Question: What form of chart is displayed?
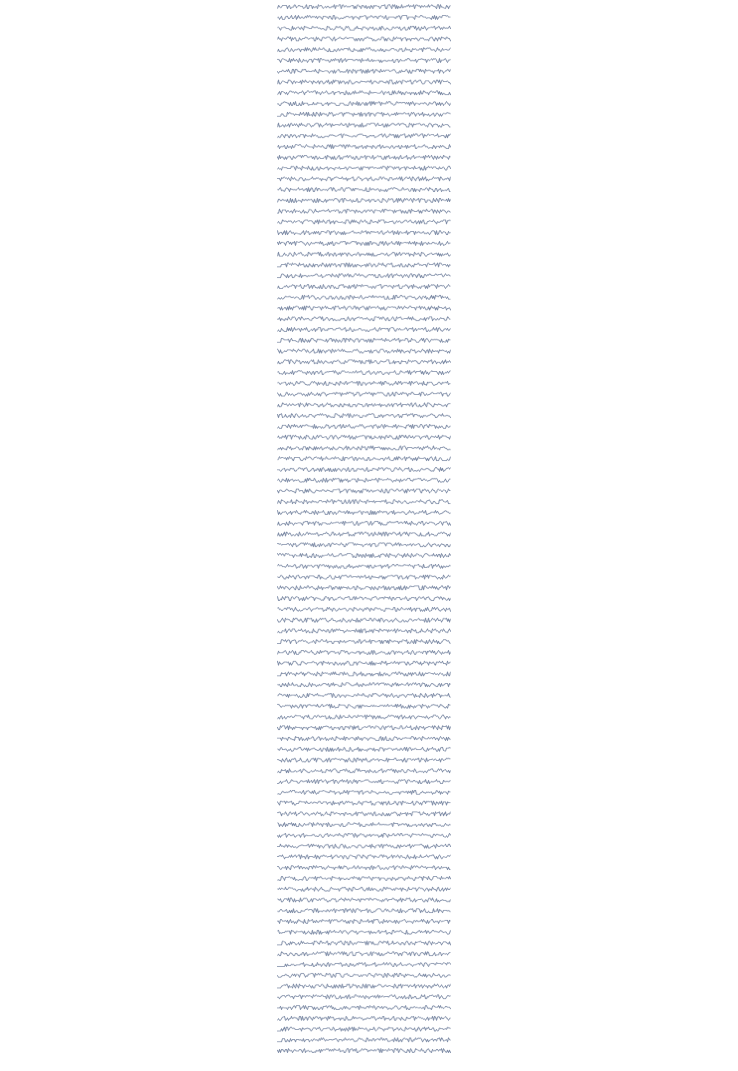
Answer: line